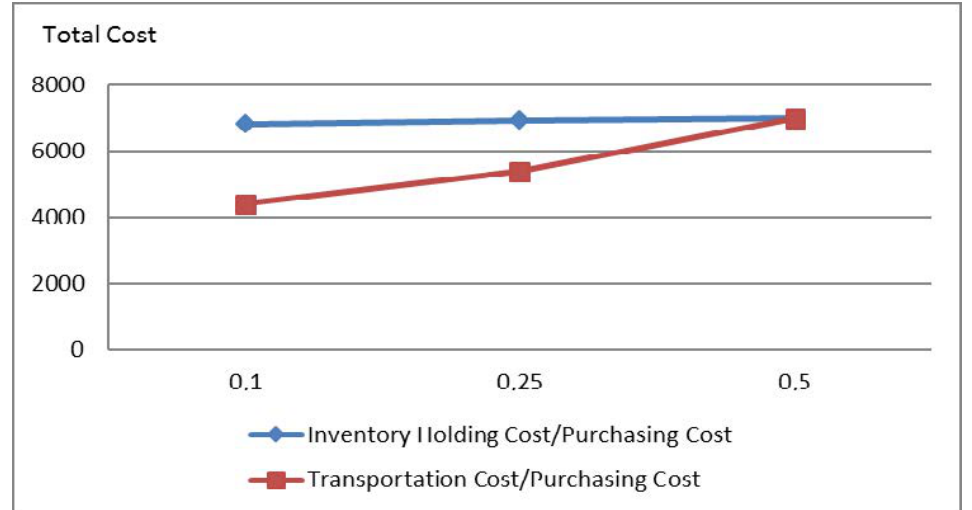
Figure 1. Effects of ratios of inventory holding cost and transportation cost over purchasing cost on the total cost.